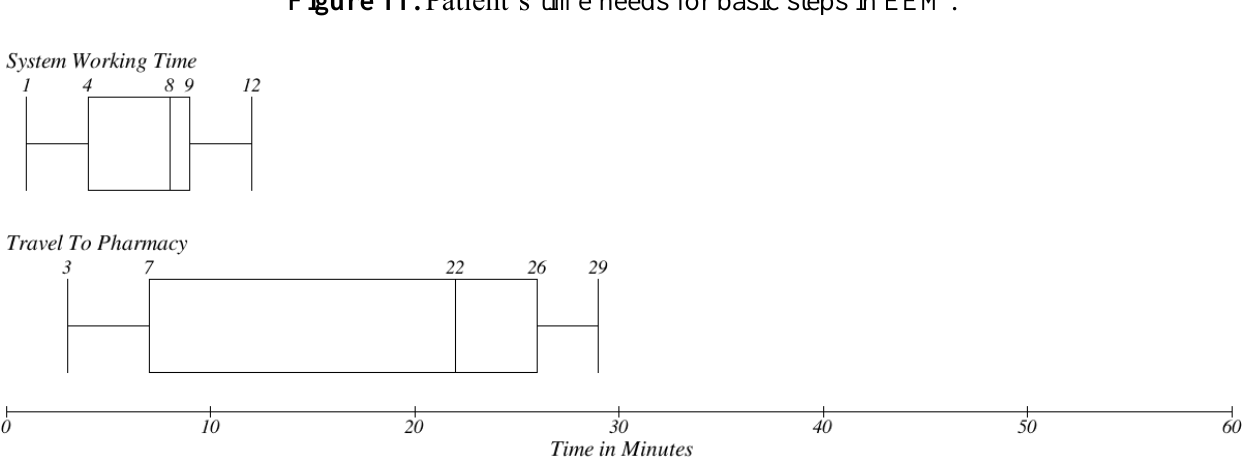
Figure 11. Patient’s time needs for basic steps in